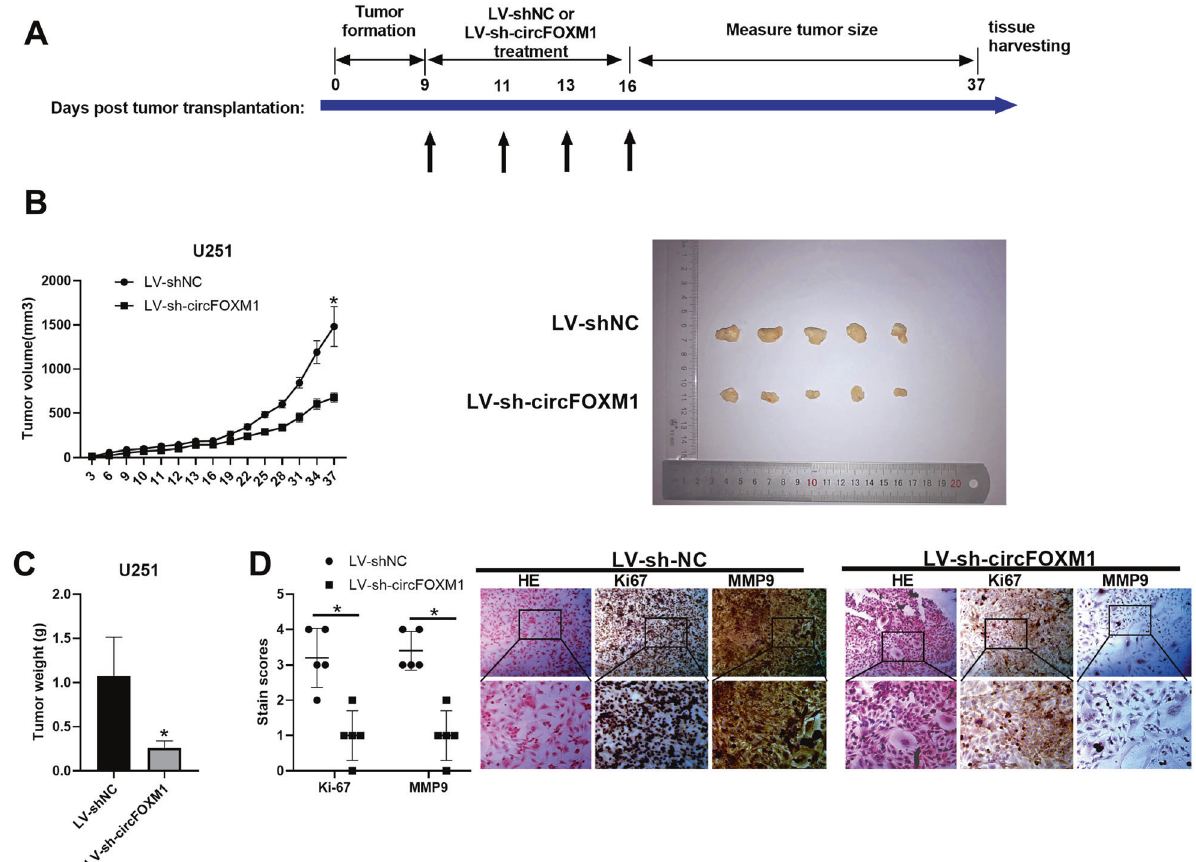
Fig. 3 Downregulation of circFOXM1 suppresses glioma progression in vivo. A Schematic diagram of the tumour-xenograft experimental process. B Tumour volume at different times measured every 3 days. C Tumour weight in the LV-sh-circFOXM1 group and LV-sh-control group. D IHC staining of Ki-67, MMP9 and EGFR expression in subcutaneous tumours (* P < 0.05) (scale bar = 100 μ m).